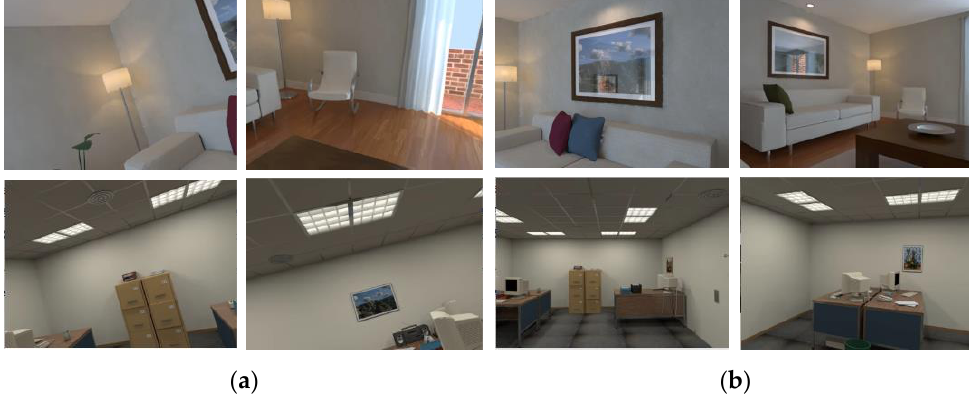
Figure 4. Two kinds of different view modes are designed in ICL-NUIM RGB-D Benchmark